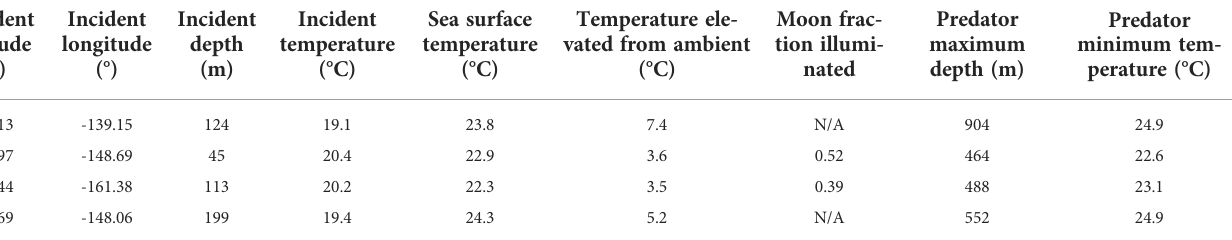
TABLE 2 Predator interactions that resulted in fi sh